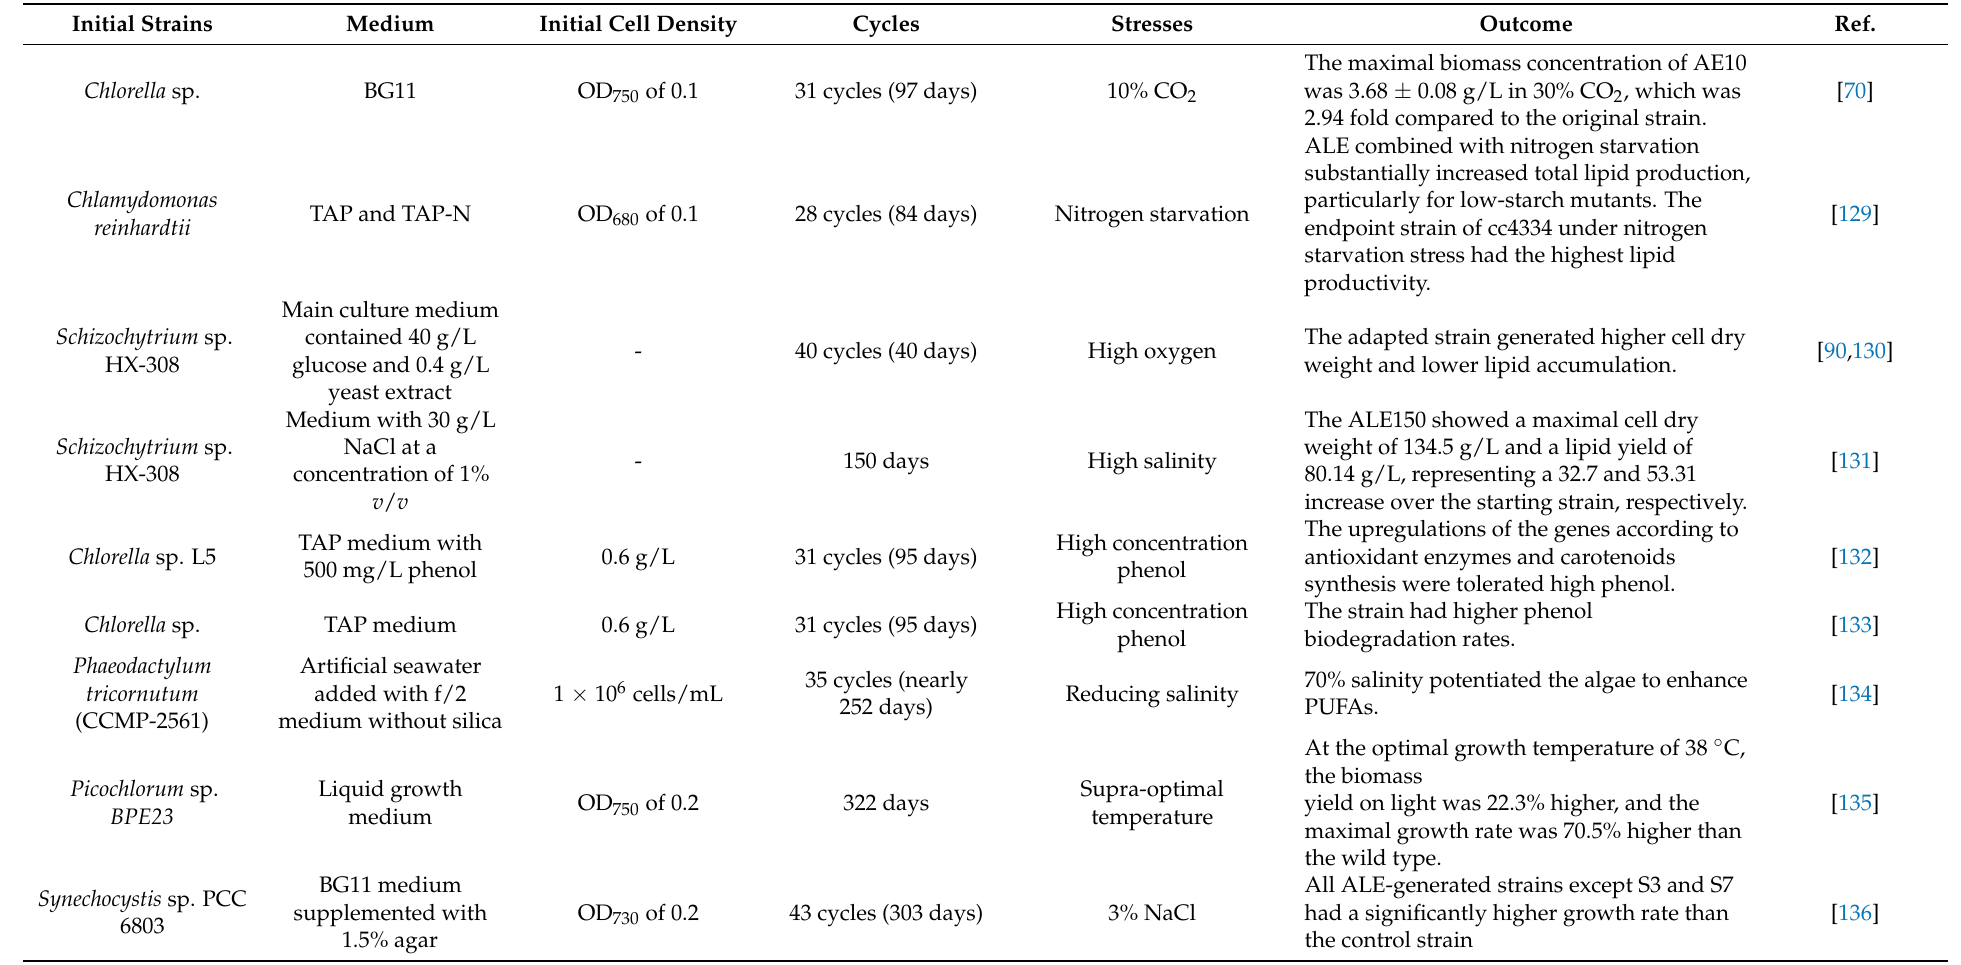
Table A1. Characteristics of the modified microalgal strains by